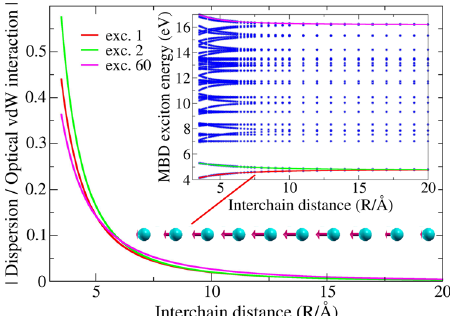
Fig. 3 Ratio between dispersion and optical-vdW interchain interaction energies for two parallel carbyne-like chains. The ratio (absolute value) between the interaction energy due to optical vdW interactions and dispersion is reported for three largely split MBD exciton modes (1,2,60), arising in parallel chains with 10 carbon atoms each (nearest-neighbor separation of 1.4 Å). Optical vdW interactions largely dominate over dispersion already at a few Å scale. The optical vdW interaction energy is de fi ned as the difference between a given exciton energy computed at fi nite R and in the R → ∞ limit. Inset: MBD exciton energies (blue dots), as a function of the interchain distance R . The analyzed excitons (1,2,60) are highlighted by colored lines, and the geometry of the plasmon-like mode 1 (over a single chain only, being the two chains identical) is illustrated. Higher-frequency longitudinal excitations will display one or more nodes (inversion points) along the structure. Identical modes in the two chains either correlate or anticorrelate due to the Coulomb coupling, leading to the observed exciton